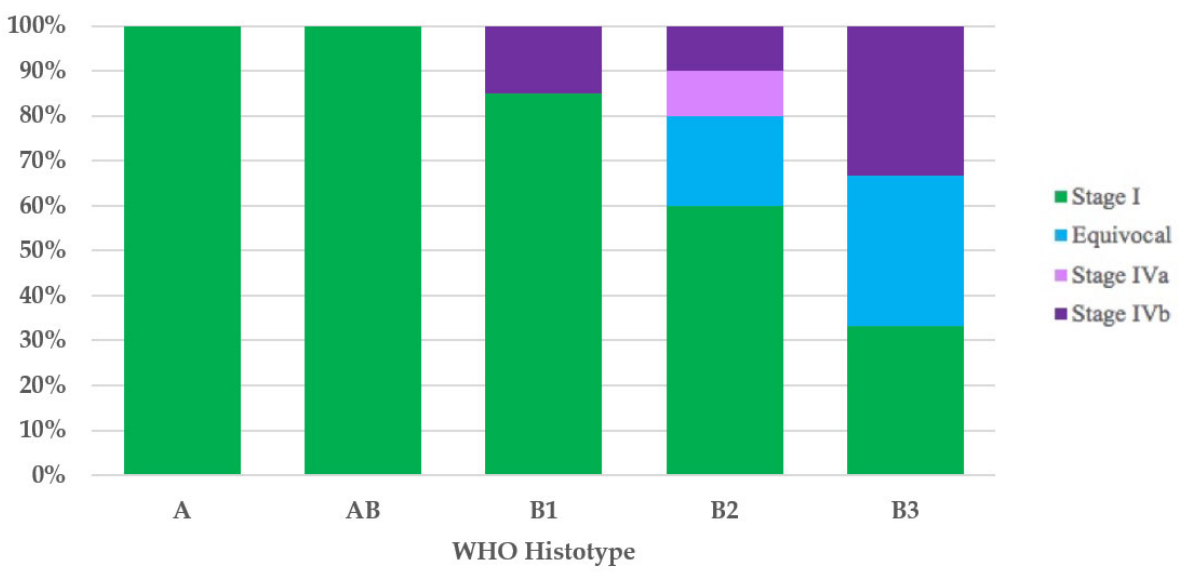
Figure 1. Stage distribution in thymoma histotypes according to the Masaoka–Koga staging system. WHO, World Health Organization.